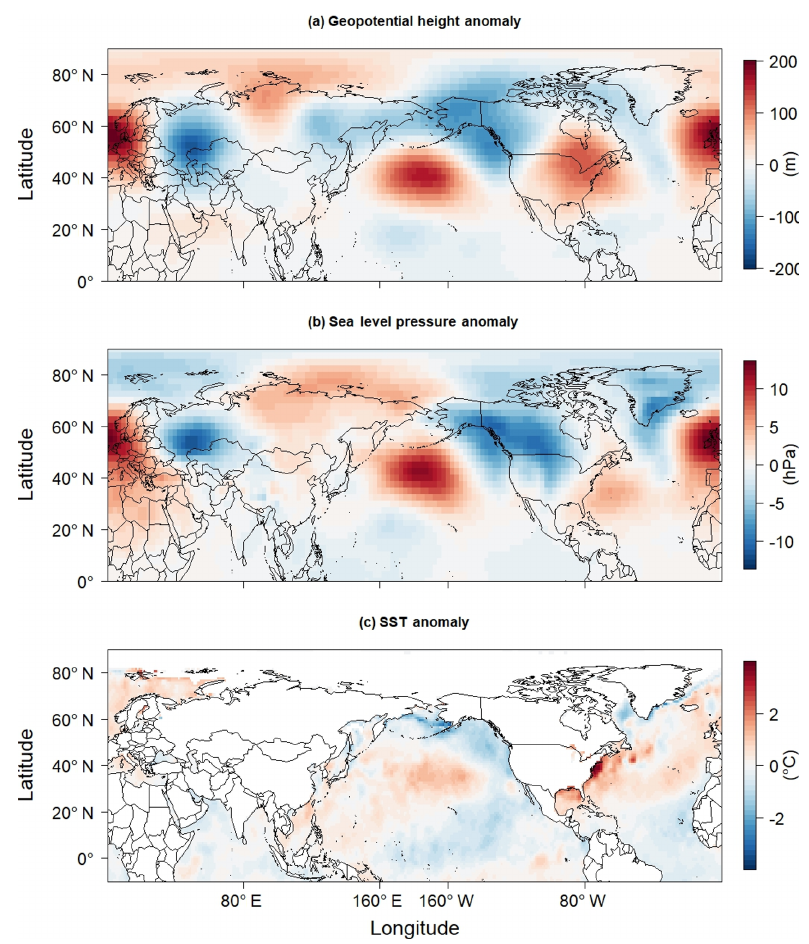
Figure 4. Anomalies for (a) 500hPa geopotential height, (b) SLP, and (c) SST corresponding to the March 2012 LIS temperature